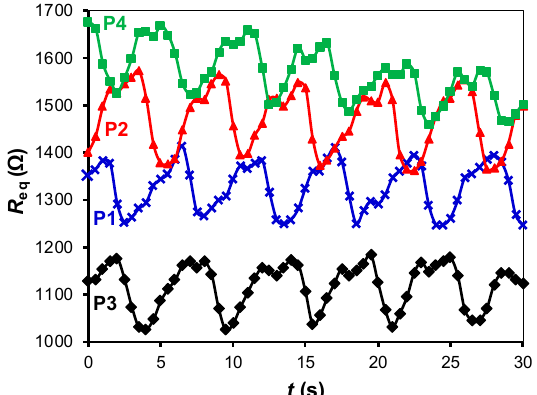
Figure 11. Small-signal resistance variations monitored by the DIC in Figure 3 for different sitting postures (see Figure 5). The test was carried with subject S2 at f s = 2 Sa/s and with C = 470